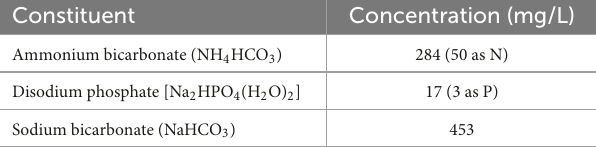
TABLE 1 Constituents of the synthetic